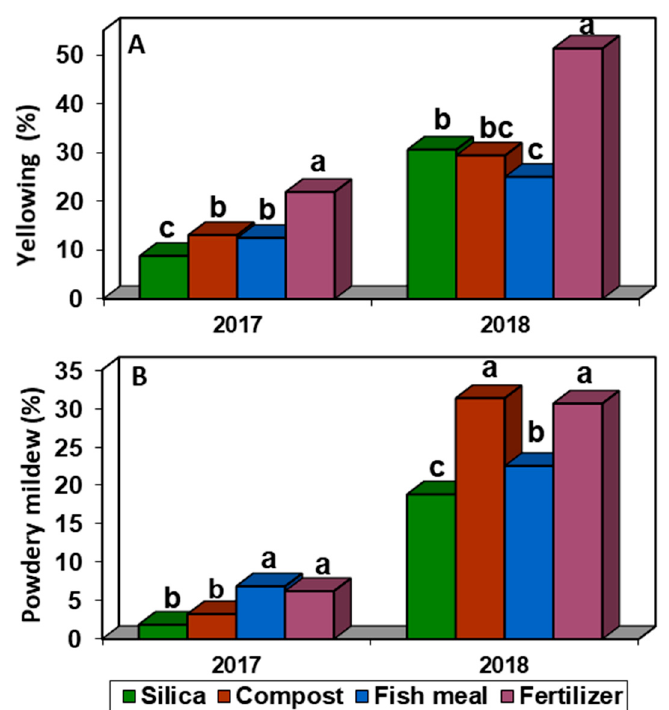
Figure 4. Effect of soil amendments on ( A ) late season yellowing and browning of green beans and ( B ) powdery mildew on zucchini squash in 2017 and 2018 growing seasons. Compost = Composted dairy manure; Silica = Compost plus silicon (Si) as Wollastonite; Fish meal = Compost plus organic fish meal (high N fertilizer); Fertilizer = commercial organic fertilizer-only treatment (no compost). Bars topped by the same letter for each year are not significantly different from each other based on ANOVA and Fisher’s protected LSD test ( p < 0.05).